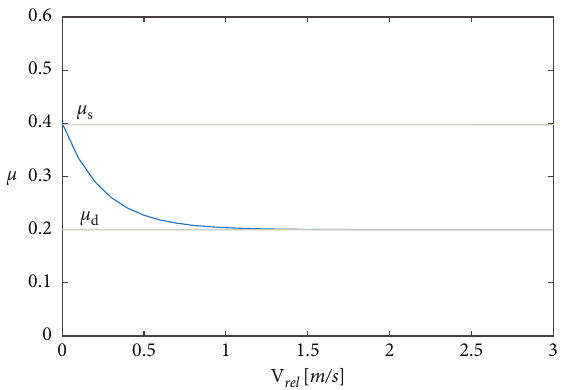
Figure 10: Dependence of friction coefficient on the relative ve- locity. Figure 10 is reproduced from